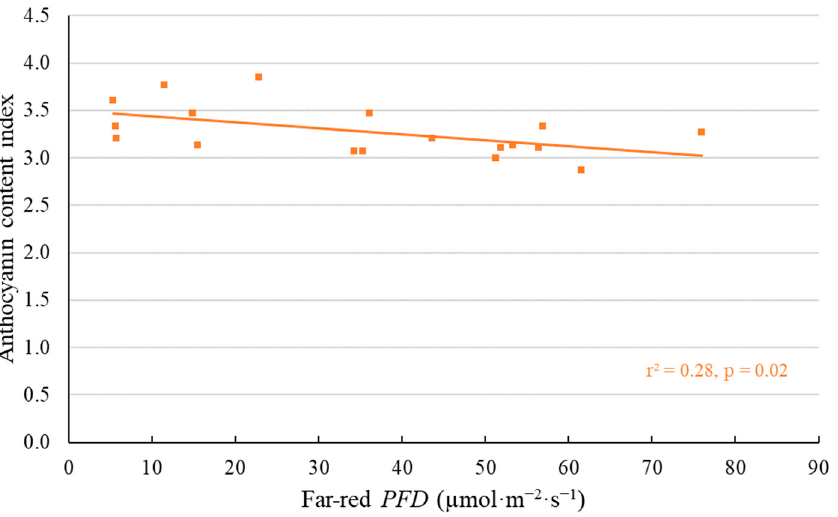
Figure 7. With a background of 204 µmol·m − 2 ·s − 1 white LED light, supplemental far-red photons linearly decreased anthocyanin content index of ‘Cherokee’ lettuce at 16 days after the start of far-red light treatment. The r 2 and p value are shown in the graph.